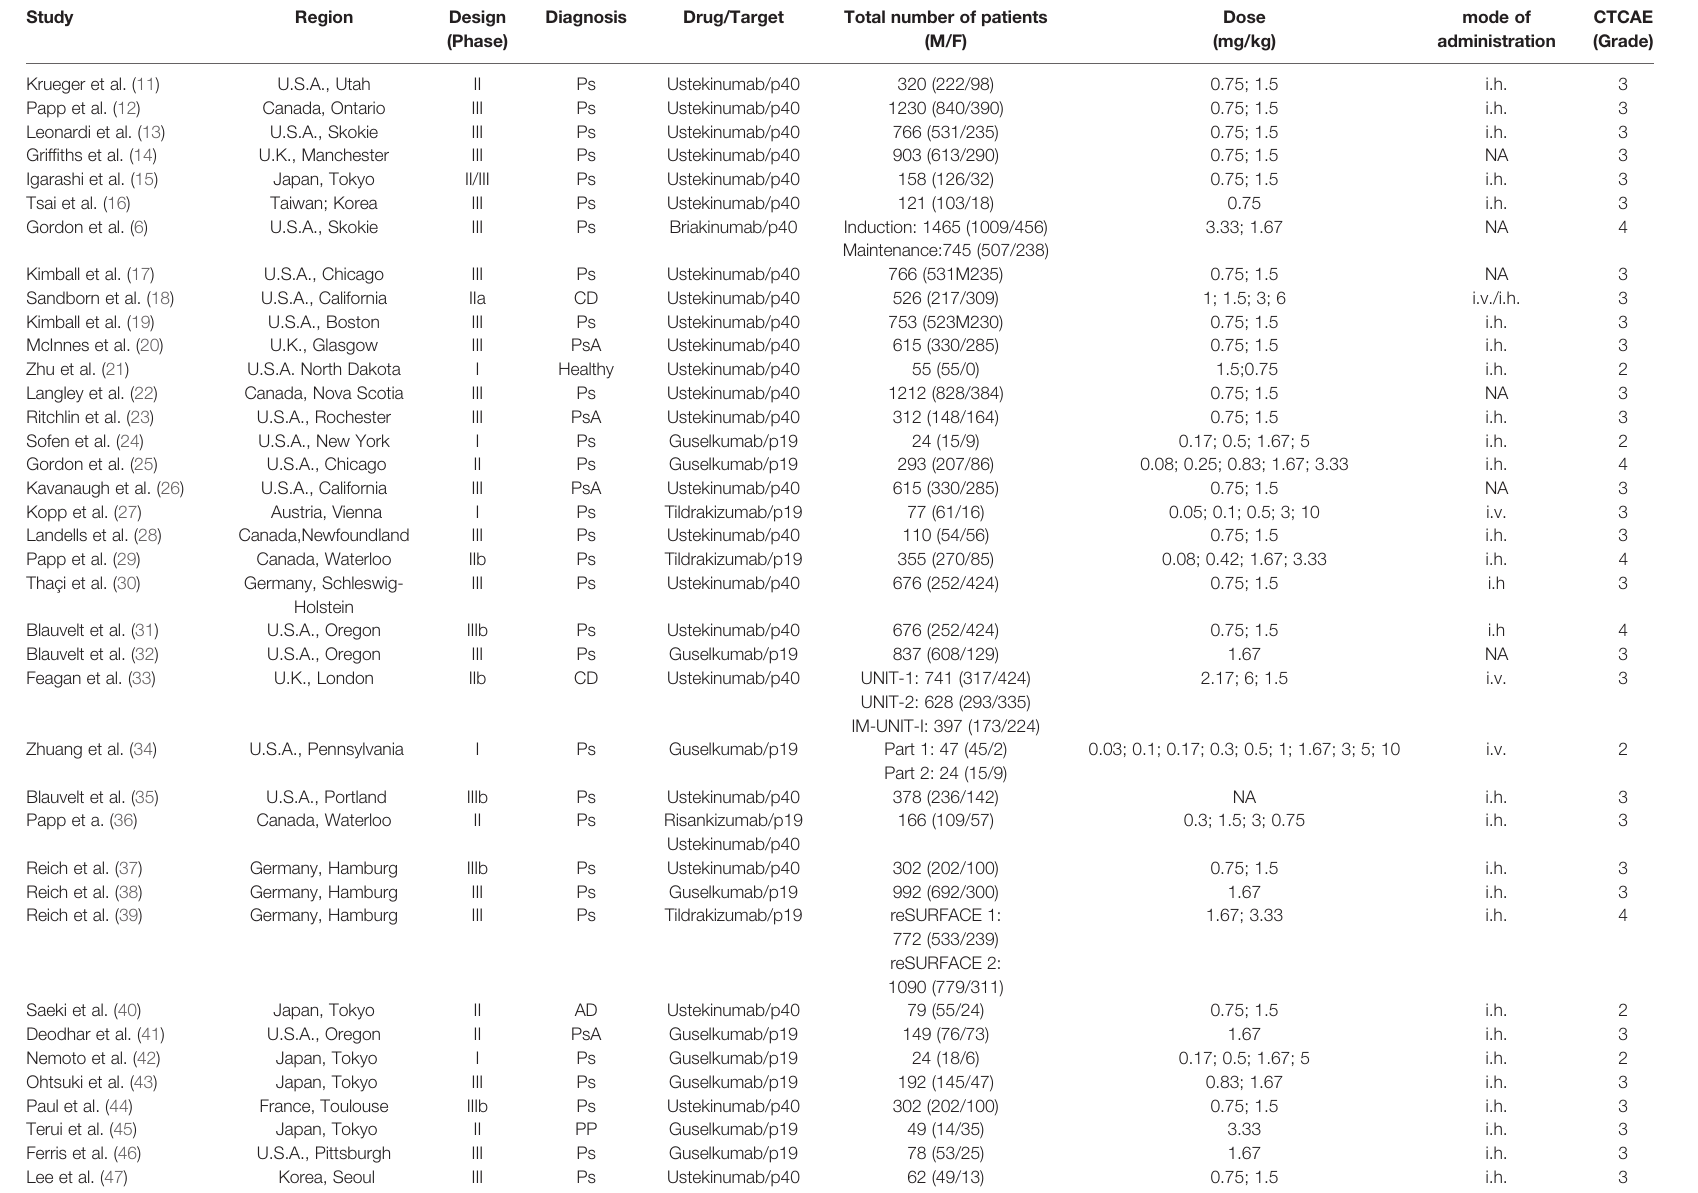
TABLE 2 | Study population characteristics: the adverse events caused by anti-IL-23 agents. Study